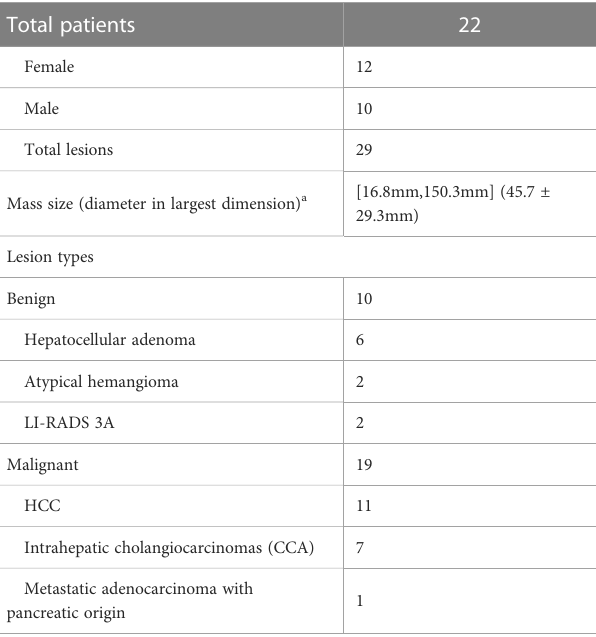
TABLE 1 Summary of the lesion